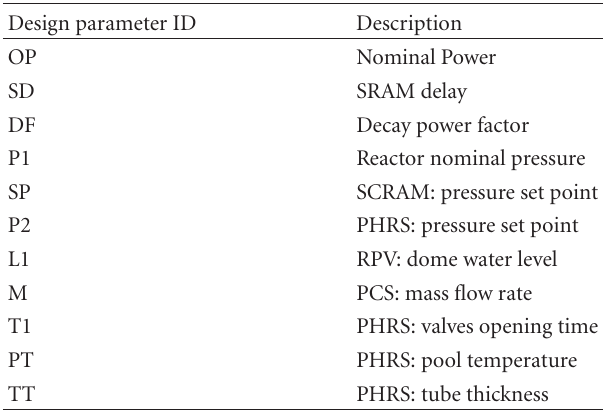
Table 1: Design parameters case a.